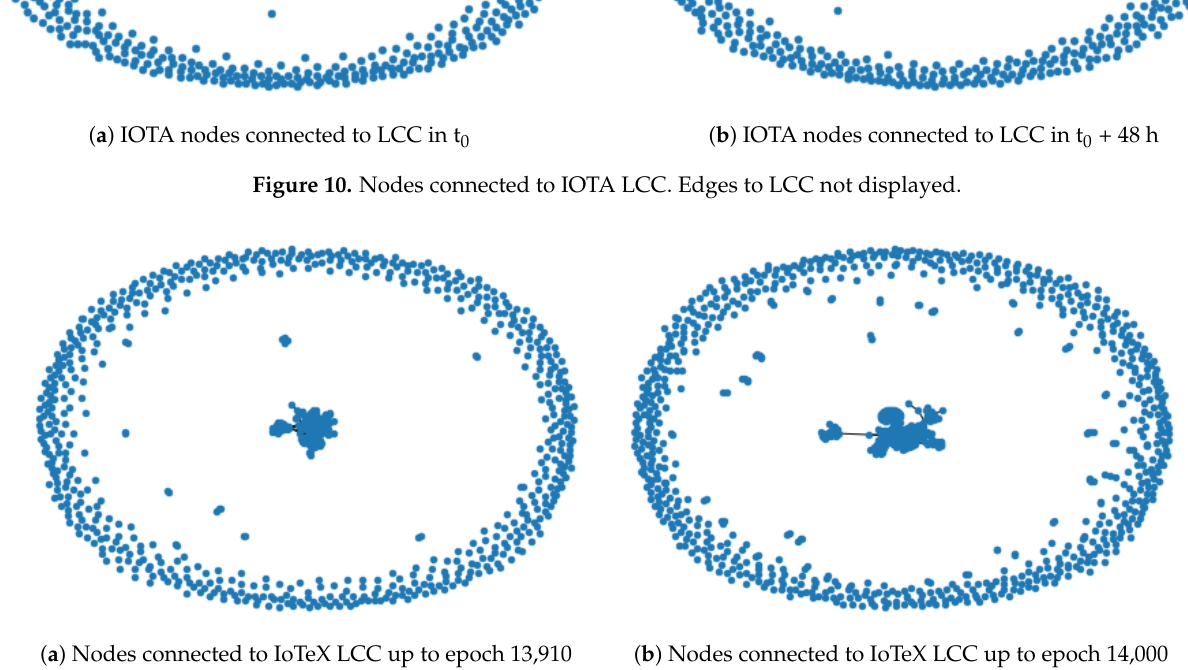
Figure 11. Nodes connected to IoTeX LCC. Edges to LCC not